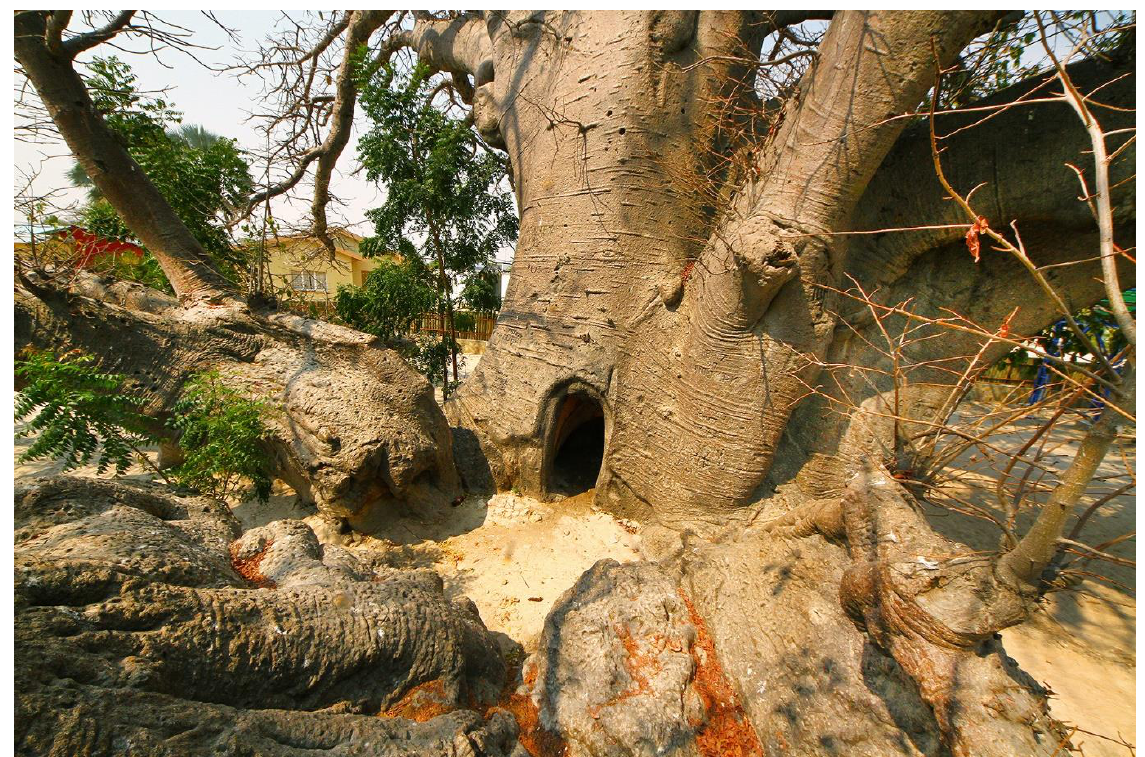
Figure 5. General view of the partially collapsed Okahao baobab inside the Okahao Baobab National Heritage Site (opened in 2013).